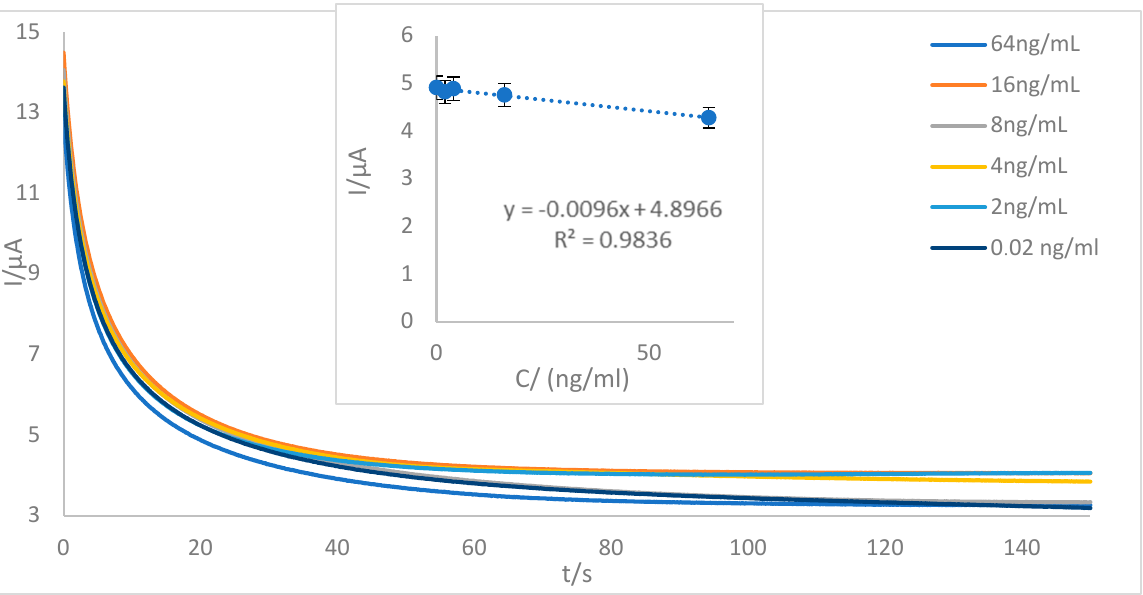
Figure 2. ChA curves of the GCE-P( β -CD)-KCC-1-NH-CS 2 in different concentrations of α -Syn (0.02, 2, 4, 8, 16, 64 ng/mL). The supporting electrolyte is 0.01 M ferricyanide/ferrocyanide. The applied potential was 0.3 V vs. Ag/AgCl, and the record time was set to 140 s. Inset: related calibration curve (n = 4, SD = 2.44). Table 2. Comparing our proposed α -syn immunosensor with other α -syn biosensors. Used Technique Bioreceptor